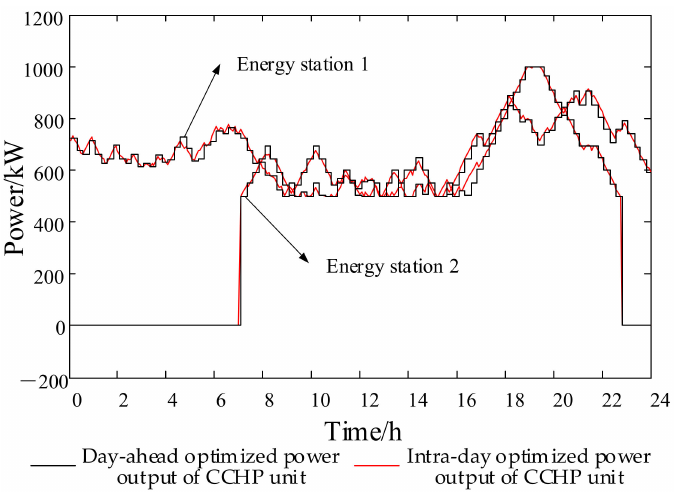
Figure 14. Day-ahead and intra-day optimized power output curves of CCHP units in the